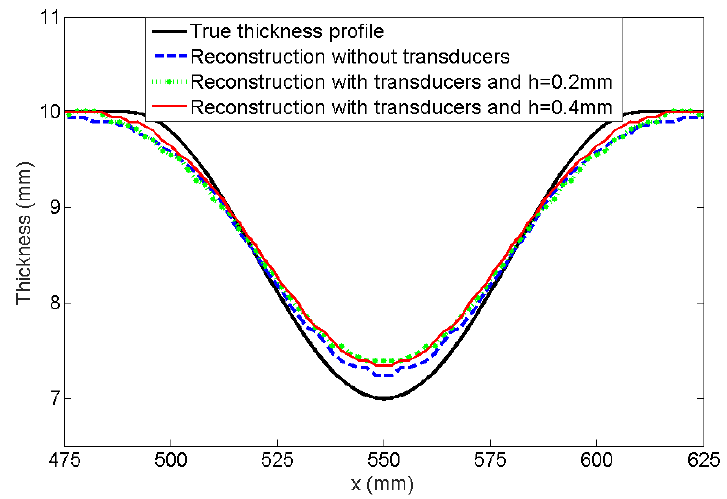
Figure 4. Thickness profiles across the reconstructions of a Hann-shaped defect with the surface diameter of 120 mm and the depth of 3 mm from the FE model without and with an array of modeled transducers. h is the thickness of the coupling